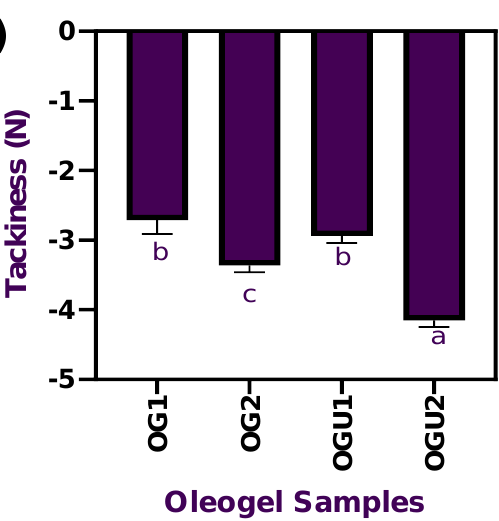
Figure 2. Hardness ( A ), stickiness ( B ), and tackiness ( C ) of palm oil-based oleogels prepared with different concentrations of carnauba wax and the ultrasonication process.